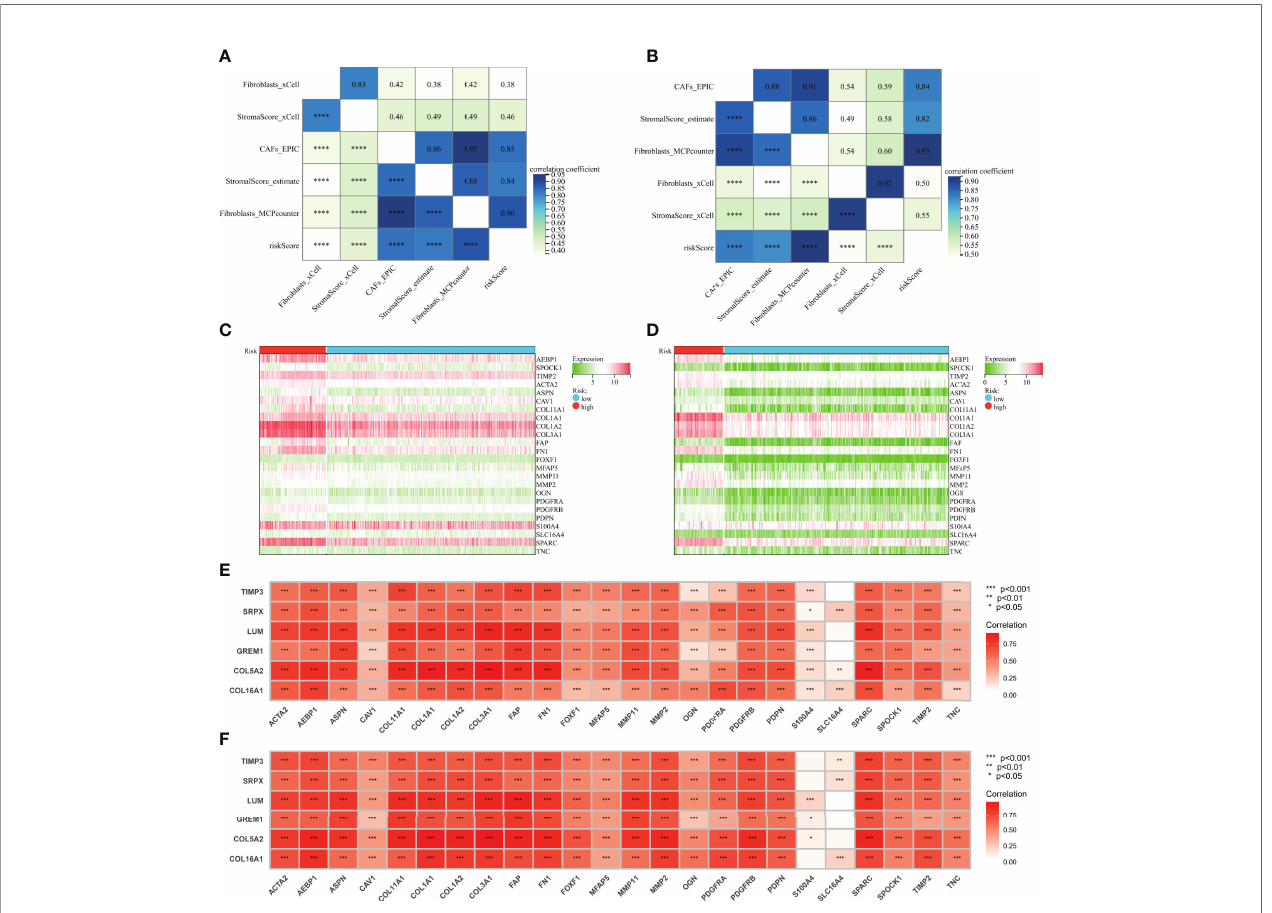
FIGURE 5 | Genes involved in the signature were correlated with CAF markers. (A) Correlation analysis of CAF score, stromal score, and risk score in the GPL570 meta-cohort. (B) Correlation analysis of CAF score, stromal score, and risk score in TCGA-OV cohort. (C) Heatmaps of expression of CAF markers in different risk groups (GPL570 meta-cohort). (D) Heatmaps of expression of CAF markers in different risk groups (TCGA-OV cohort). (E) Correlation analysis of genes involved in signature and CAF markers (GPL570 meta-cohort). (F) Correlation analysis of genes involved in signature and CAF markers (TCGA-OV cohort). CAFs, Cancer- Associated